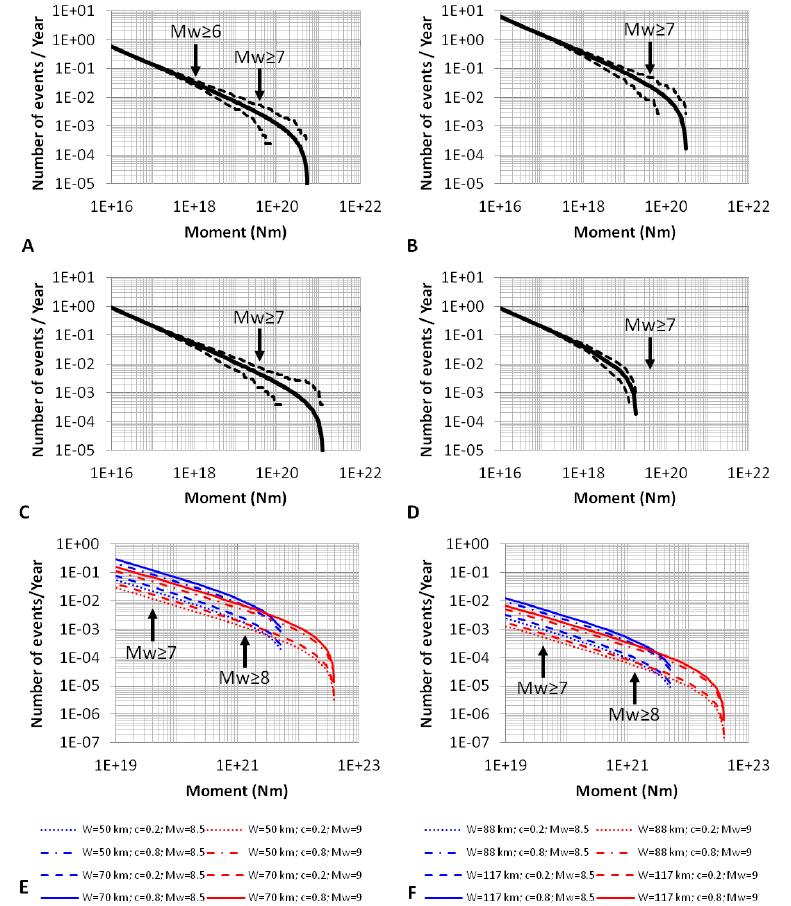
Fig. 5. (a–d) Diagrams showing the cumulative moment–frequency distribution (bold solid line) of crustal fault sources, grouped according to regional tectonic properties, based on the restrained Pareto distribution from Kagan (2002b) and constrained by the summed tectonic moment rate (Table 5): (a) Hellenides Fold-and-thrust Belt; (b) Ionian Island Transform Fault Zone; (c) Calabrian Accretionary Wedge; (d) Sicily–Tunisia Graben. The dashed lines show the cumulative minimum and maximum number of earthquakes from 100 sets of 1000 random samples according to these distributions. (e–f) Diagrams showing the cumulative MFD of subduction sources (slab interface) based on the restrained Pareto distribution from Kagan (2002b) and constrained by the tectonic moment rate (Table 4): (e) Hellenic Arc; (f) Calabrian Arc. W : width of slab interface constrained by seismogenic depth and average dip angle; c : long-term aseismic factor; M w : magnitude upper